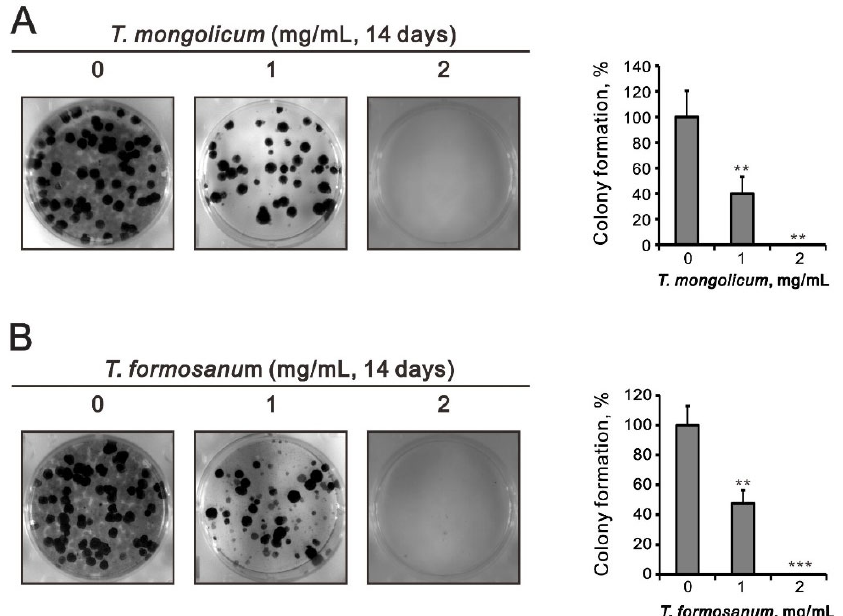
Figure 4. Effects of T. mongolicum and T. formosanum on colony formation by MDA ‐ MB ‐ 231 cells. MDA ‐ MB ‐ 231 cells were treated for 14 days with the indicated concentrations of ( A ) T. mongolicum or ( B ) T. formosanum . They were then subjected to colony formation analysis. The results are repre ‐ sentative of three independent experiments. Bars depict the mean ±SD. ** p < 0.01. *** p < 0.001.